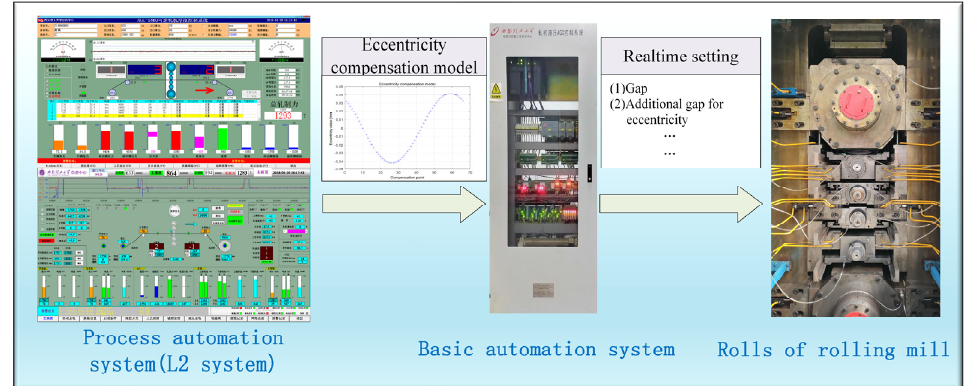
Figure 9. The rolls of six-roller reversible cold rolling mill and the control system of cold rolling mill. The data used to detect the roll eccentricity signals were obtained from the rolling force and outlet thickness deviation data collected on site. The specific steps include: